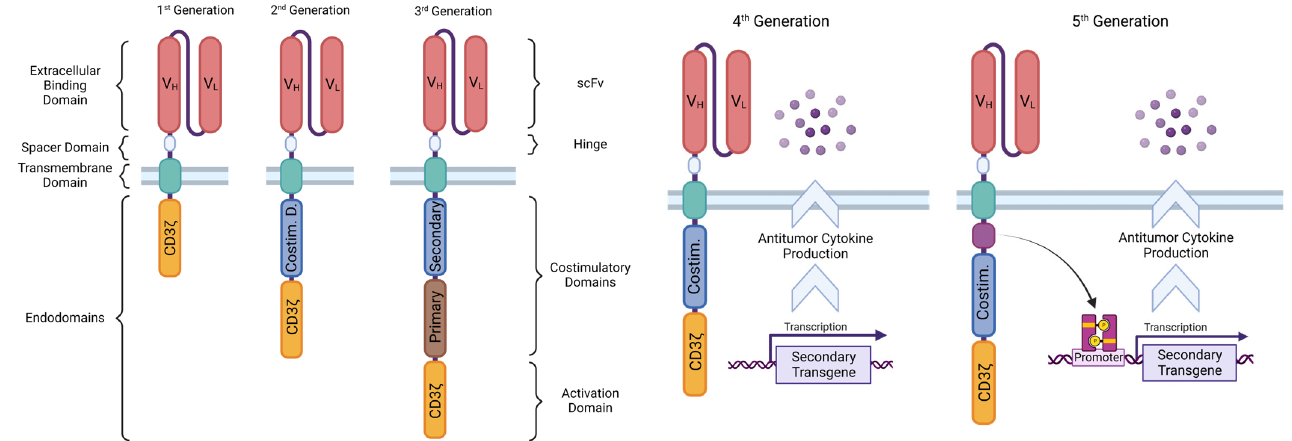
Figure 2. Chimeric antigen receptor designs, ordered by their corresponding conceptual generation.